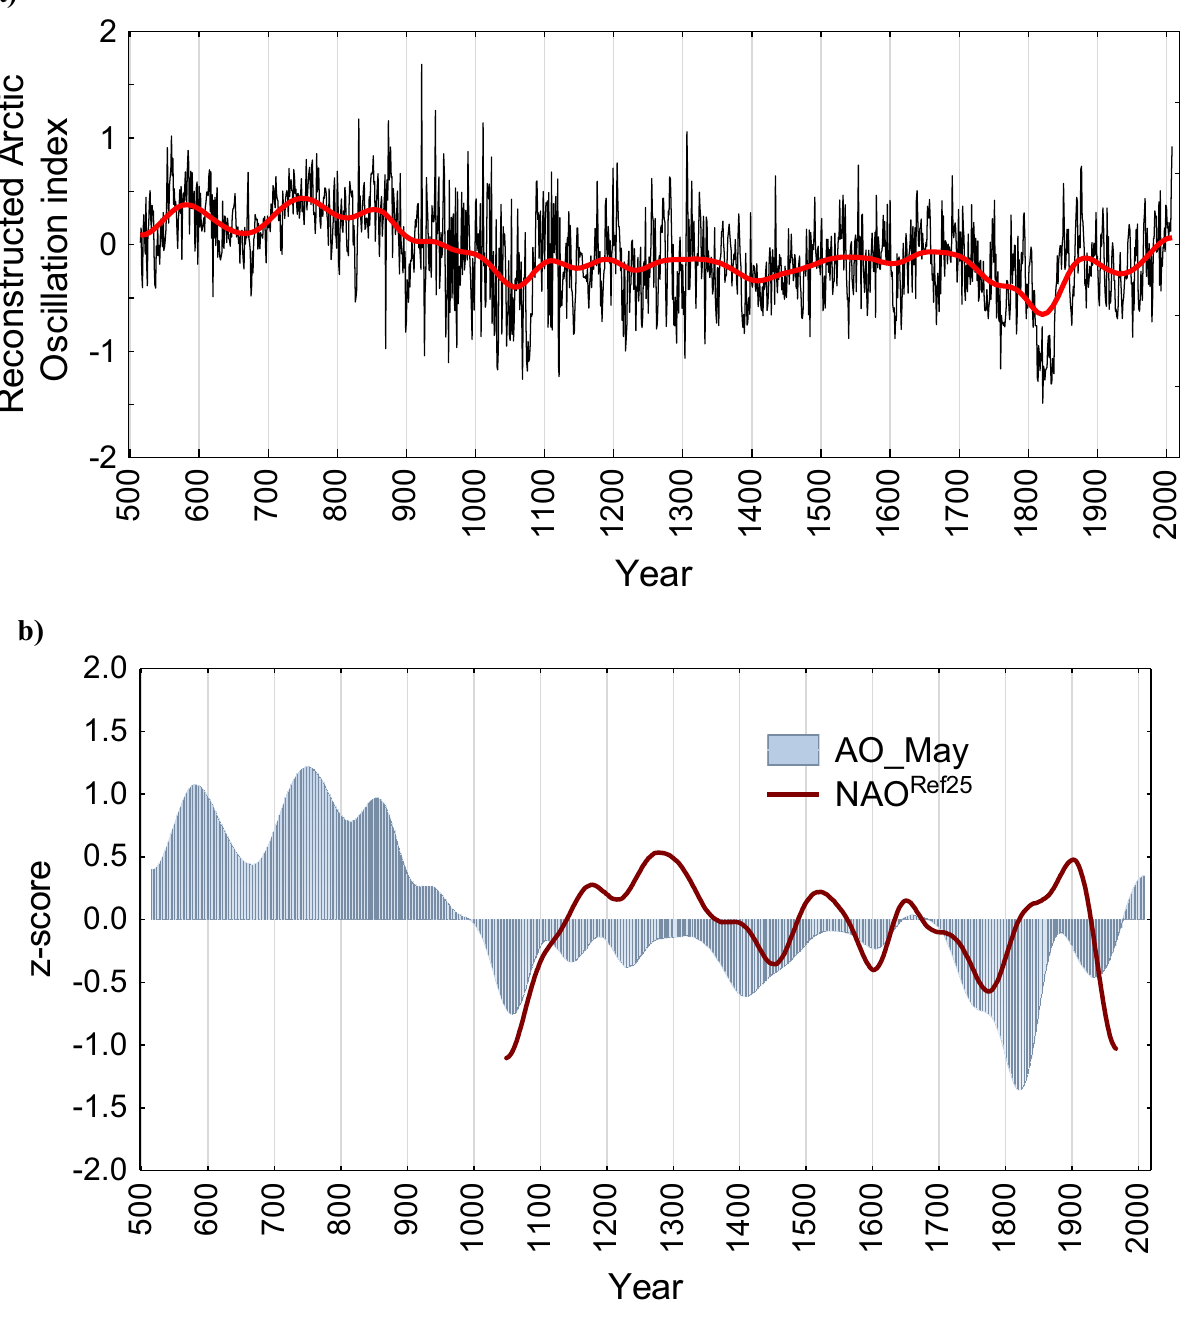
Figure 4. Annually-resolved reconstructed Arctic Oscillation (AO) index in May inferred from δ 18 O tree-ring cellulose ( a ) and smoothed by a 101-year Hamming window AO index in May in comparison with a proxy- based North Atlantic Oscillation (NAO) 25 ( b